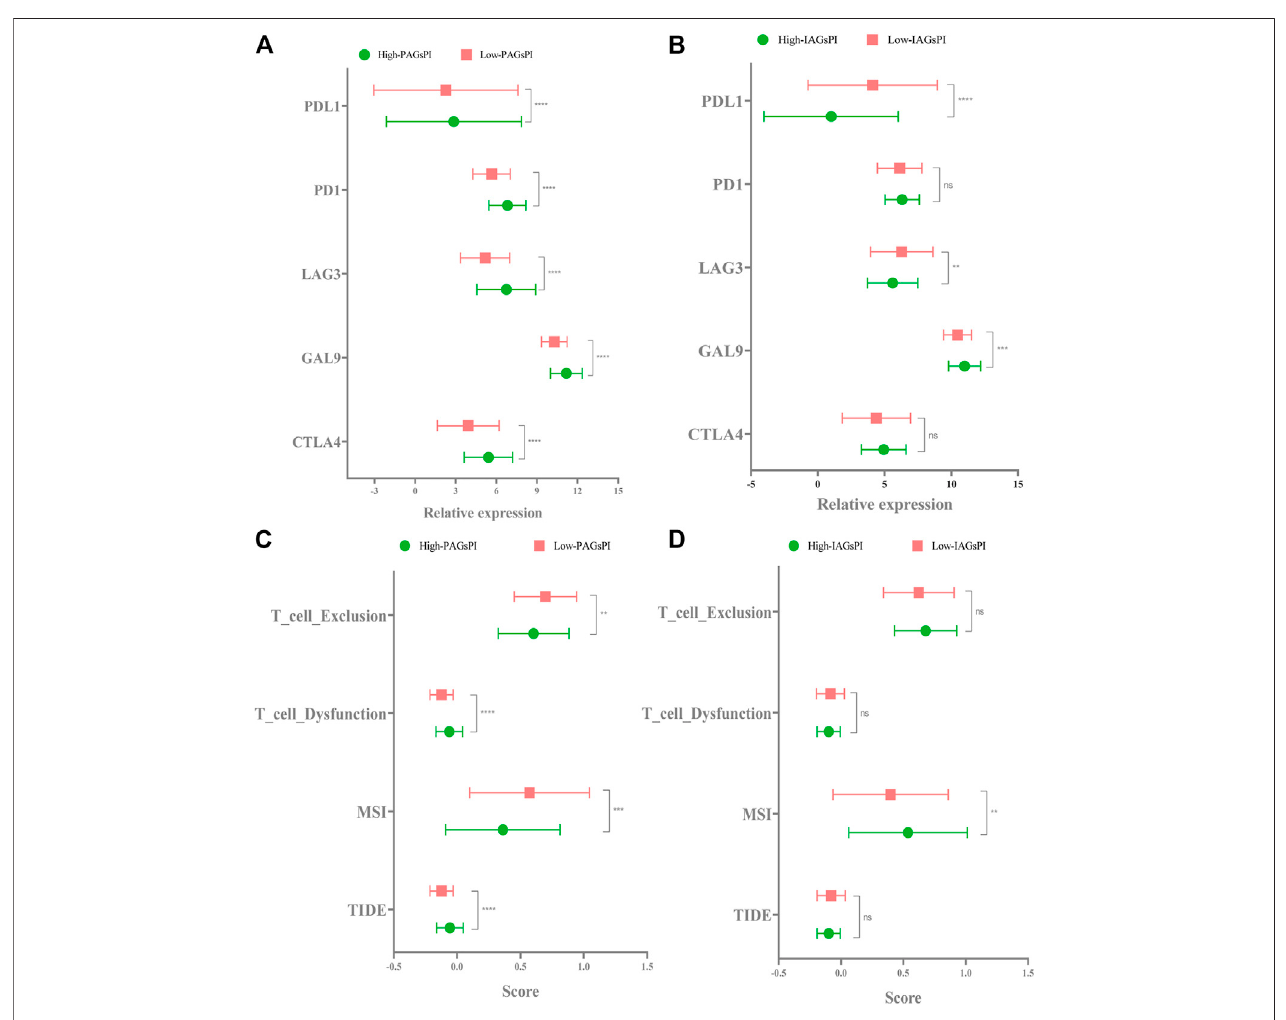
FIGURE 8 | Response to immunotherapy. (A,B) In the training dataset, the expression of CTLA4, GAL9, LAG3, PD1 and PDL1 in the PAGsPI and IAGsPI subgroups were compared. (C,D) The TIDE, MSI, T cell dysfunction and T cell exclusion scores were compared in the PAGsPI and IAGsPI subgroup.